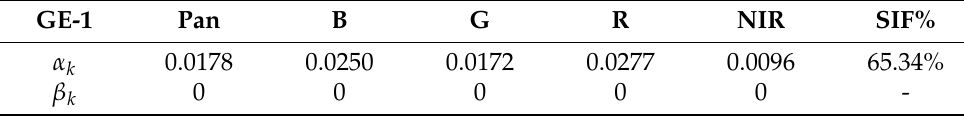
Table 1. Gains and offsets for conversion to SR of GeoEye-1—Collazzone.